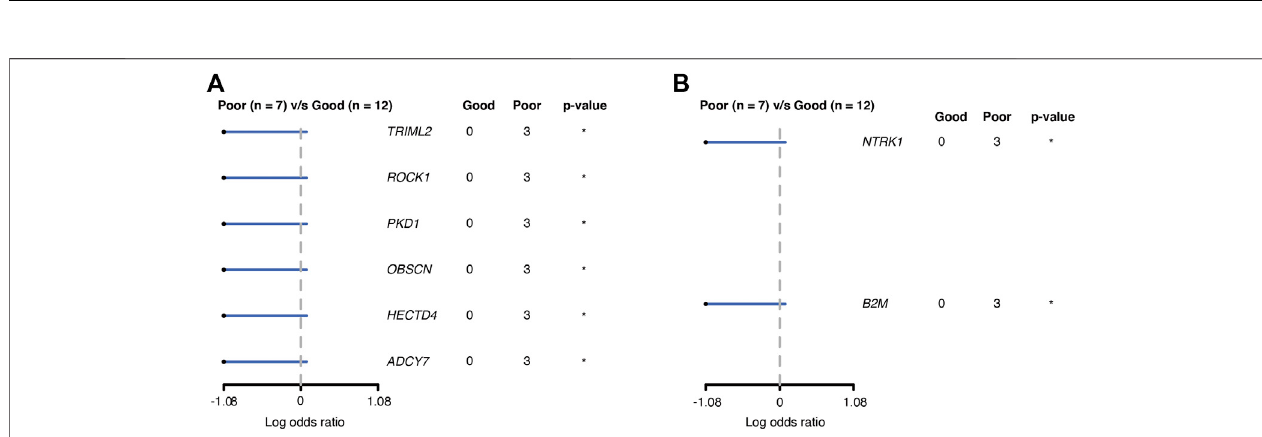
FIGURE 5 | Genes associated with PFS6 prognosis in GBM patients. (A) Genes with SNV; (B) genes with CNV. *: p < 0.05.